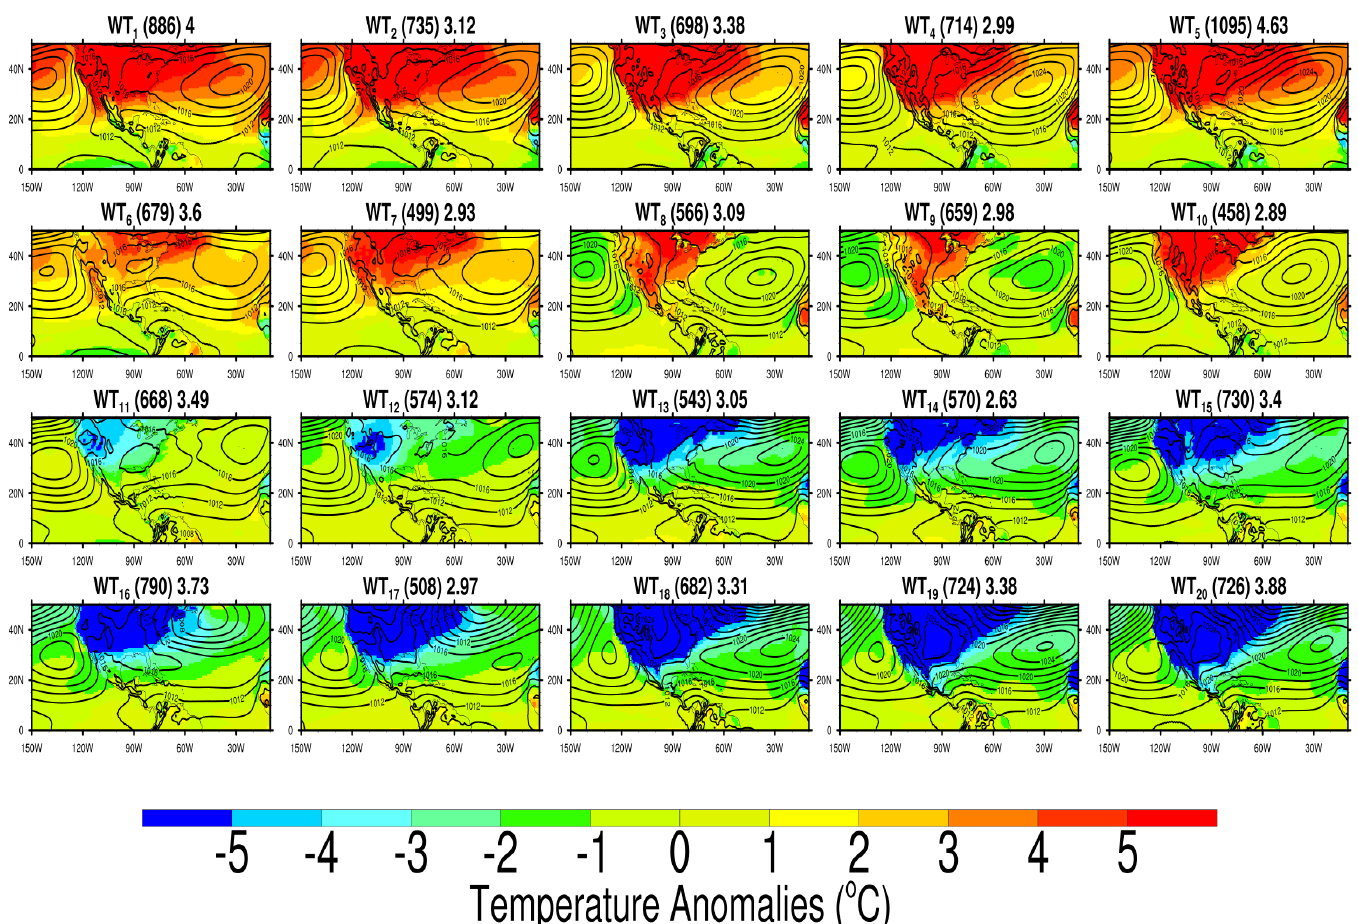
Figure 1. Composite averages of mean sea-level pressure (contours from 988 to 1028, by 2 hPa) and 2 m air temperature anomaly (colors) fields per self-organizing map (SOM) node. The number of days each Weather Type (WT) is present in climatology is indicated in parentheses and mean persistence is indicated outside the parentheses to the